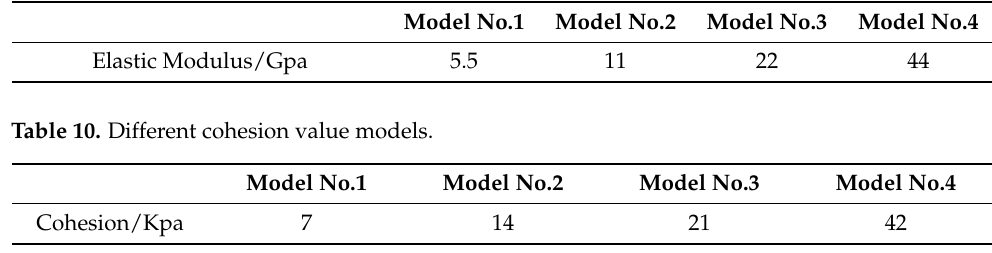
Table 11. Different internal friction angle value models.